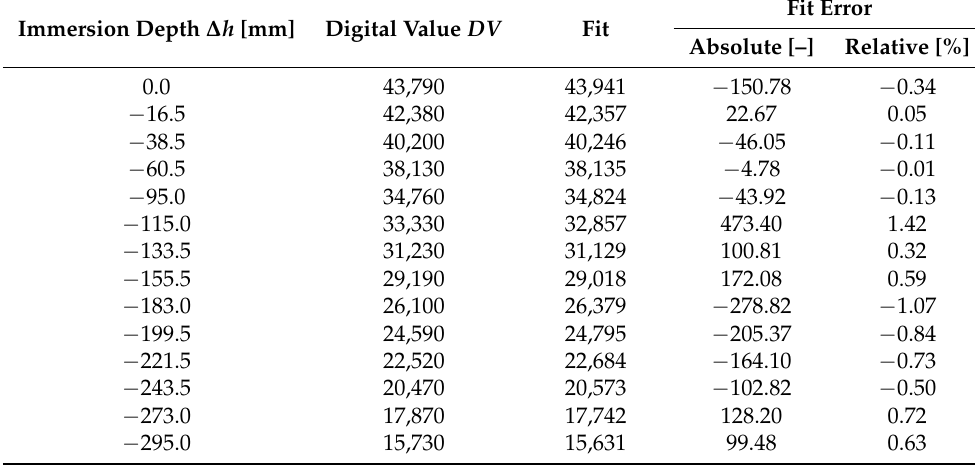
Table 2. Data of sensor in static characteristic linearity verification.